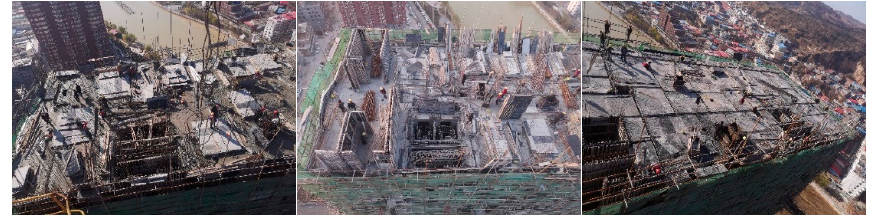
Figure 1. Examples of chaotic construction sites.